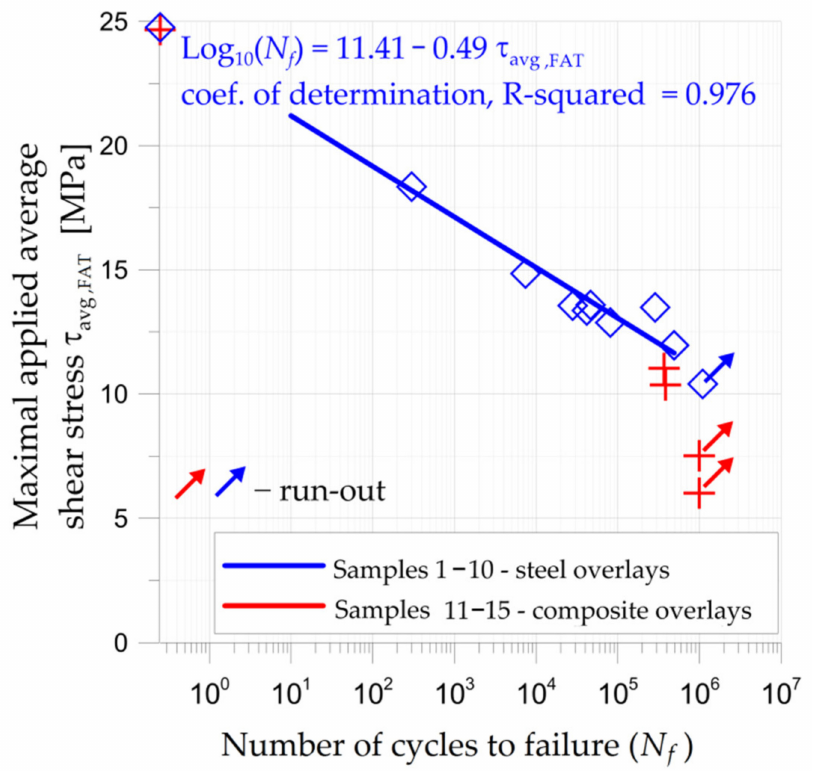
Figure 16. Results of fatigue tests for samples with double-lap joints.